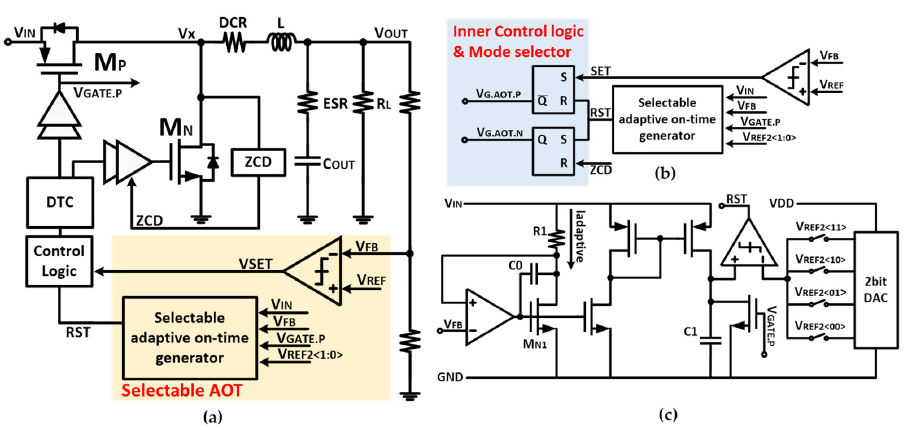
Figure 3. PFM buck converter with proposed selectable adaptive on-time control: ( a ) buck converter structure, ( b ) selectable adaptive on-time controller, and ( c ) selectable adaptive on-time generator.